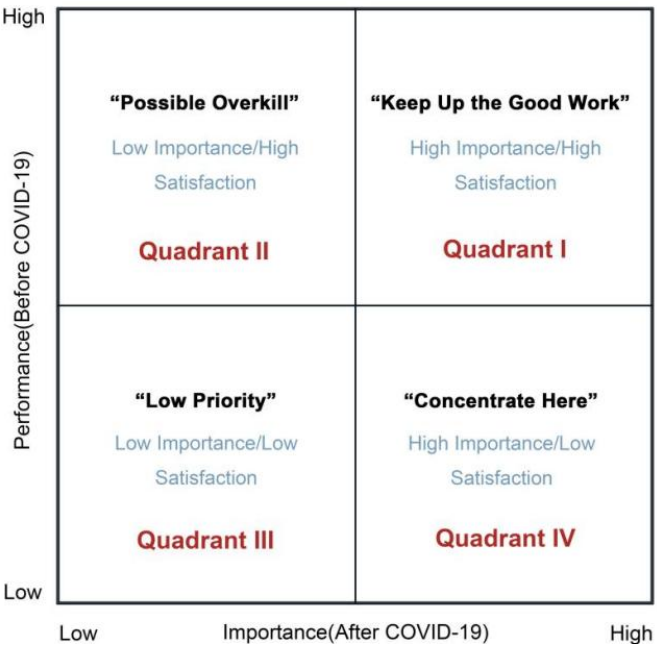
Figure 3. The importance–performance analysis (IPA)